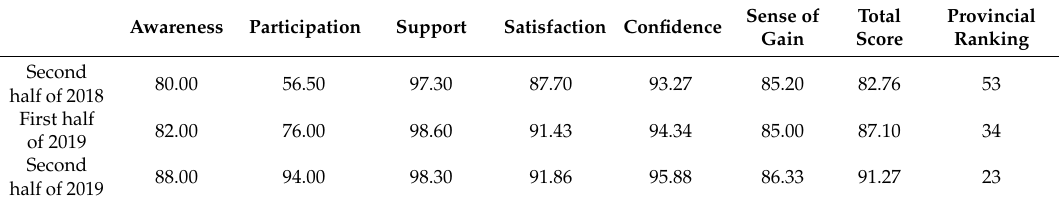
Table 3. Crowd satisfaction scores and rankings of the RCS in Deqing